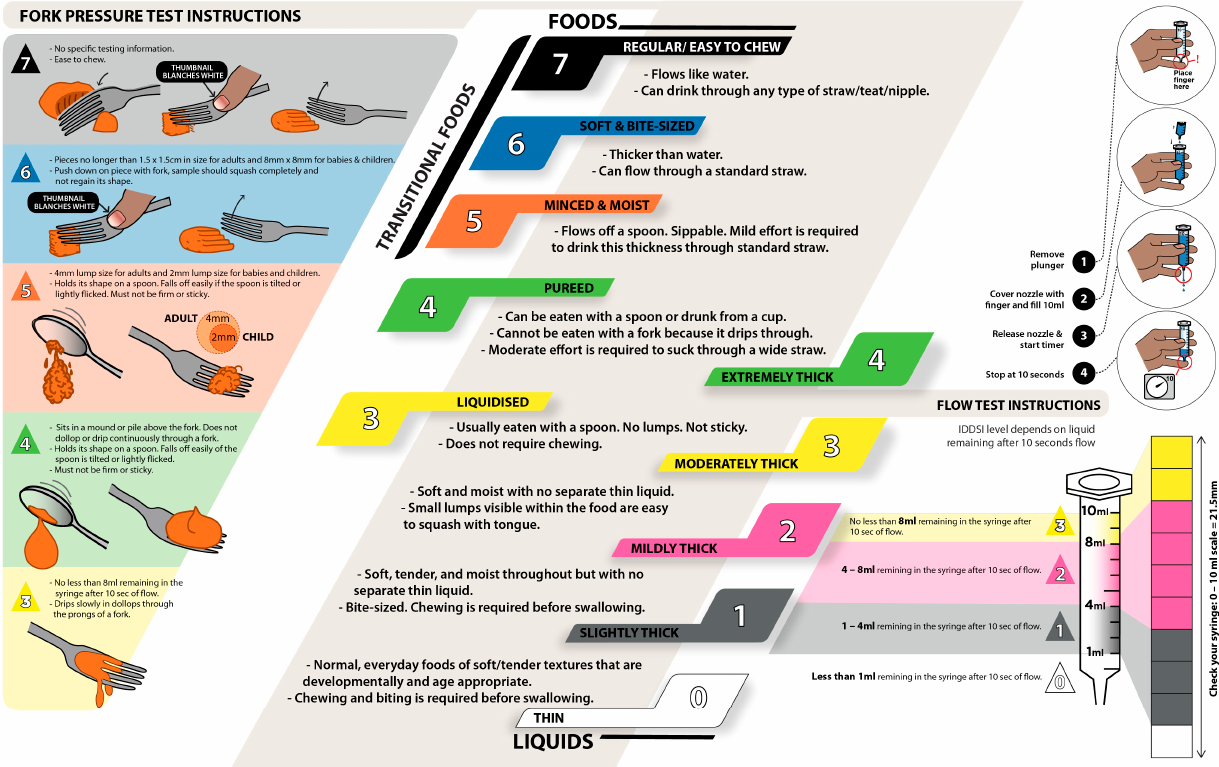
Figure 2. Food and liquid samples prepared according to the fork pressure test and flow test from the International Dysphagia Diet Standardization Initiative (IDDSI) framework (original figure, information acquired from © The International Dysphagia Diet Standardization Initiative 2019, @ https://iddsi.org/framework/Licensed (accessed on 5 February 2023) under the CreativeCommons Attribution Sharealike 4.0 License: https://creativecommons.org/licenses/by-sa/4.0/legalcode (accessed on 5 February 2023)).